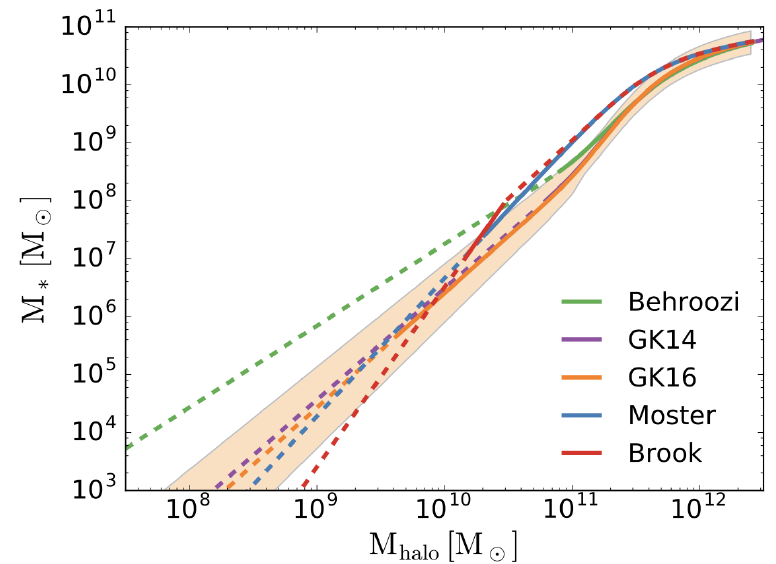
Figure 8. Abundance matching (AM) relations from the models by Behrooz [268], Garrison-Kimmel GK14 [269], Garrison-Kimmel GK16 [267], Moster [270], and Brook [271]. The solid lines show the models in a region of the parameter space where observational data are available; the dashed lines show the extrapolation of the models where the observational information is missing. The orange shaded area show the 1 σ log-normal scatter around the model GK16. The figure is from